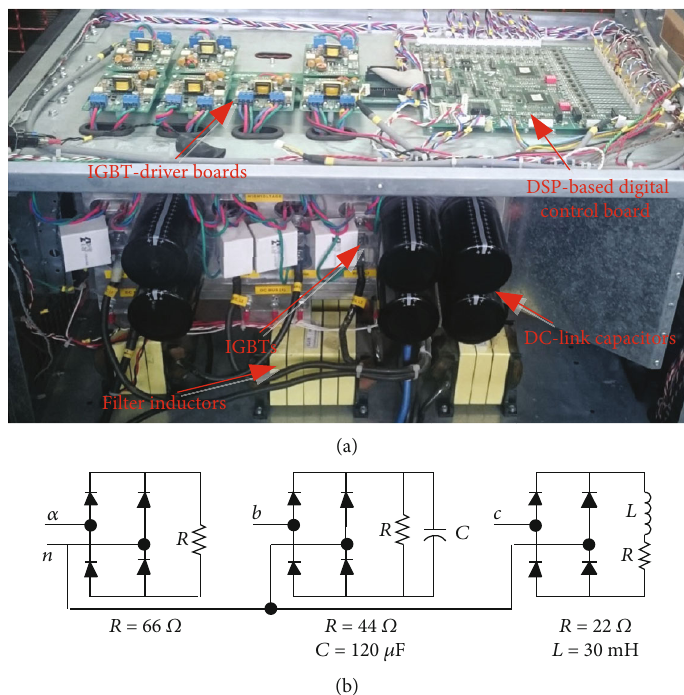
Figure 4: (a) The photograph of the test bench. (b) The structure of under tested nonlinear